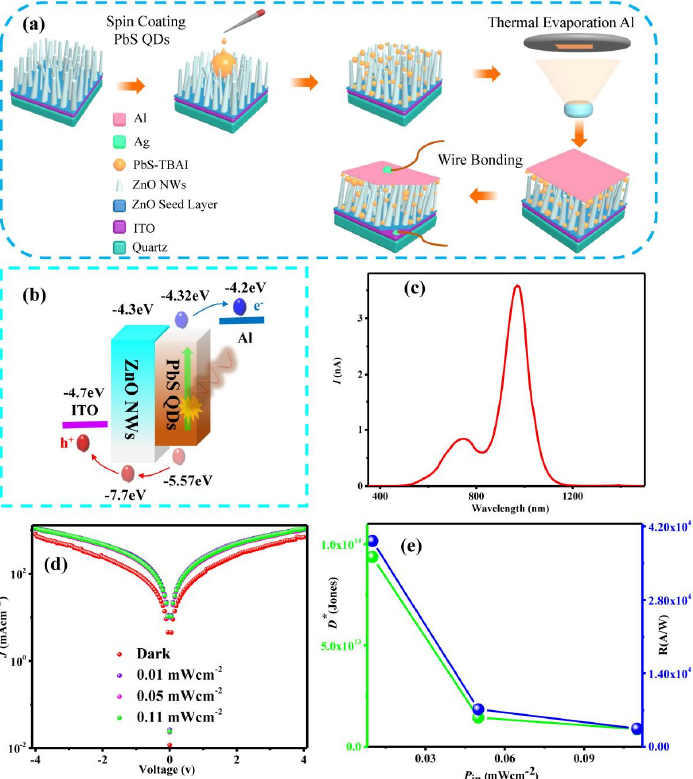
Figure 3. Fabrication and performance of the photodetector based on ZnO NWs/PbS CQDs hybrid nanostructures. ( a ) Schematic diagram illustrating the fabrication process of the photodetector. ( b )The energy band diagram of the photodetector. ( c ) The photocurrent spectrum of the photodetector. ( d ) J-V characteristics of the photodetector at different infrared power densities ( λ = 940 nm). ( e ) Responsivity and detectivity plots of the